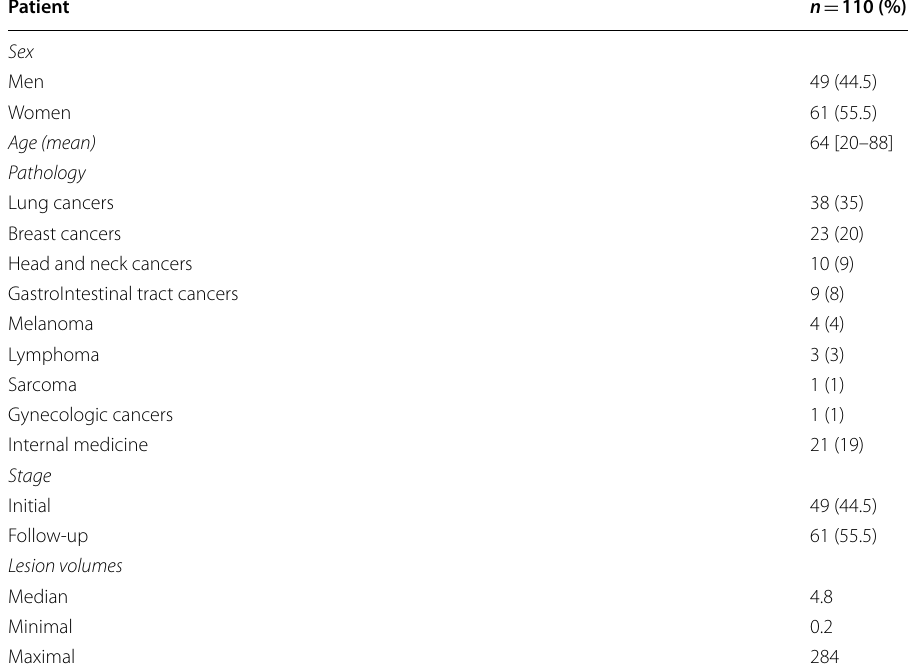
SP, PET50, PET50 SP + +